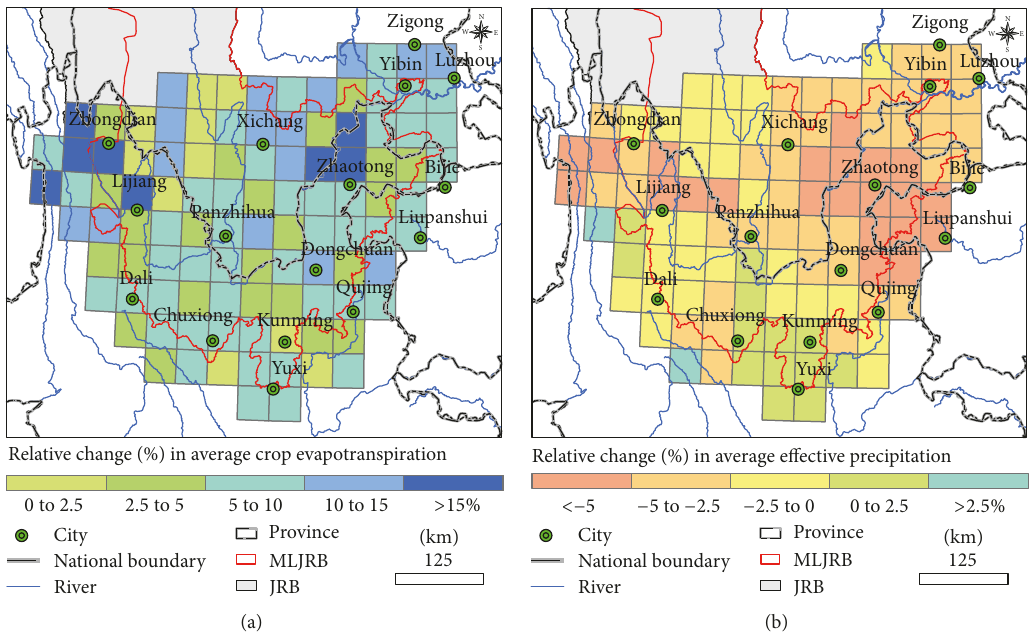
Figure 15: Spatial distribution of the percentage change in crop evapotranspiration and effective precipitation (%) from the reference period (1961–1990) to